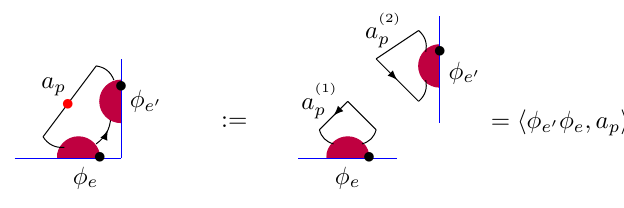
Figure 11 . Gluing edges with the coproduct of H cop .